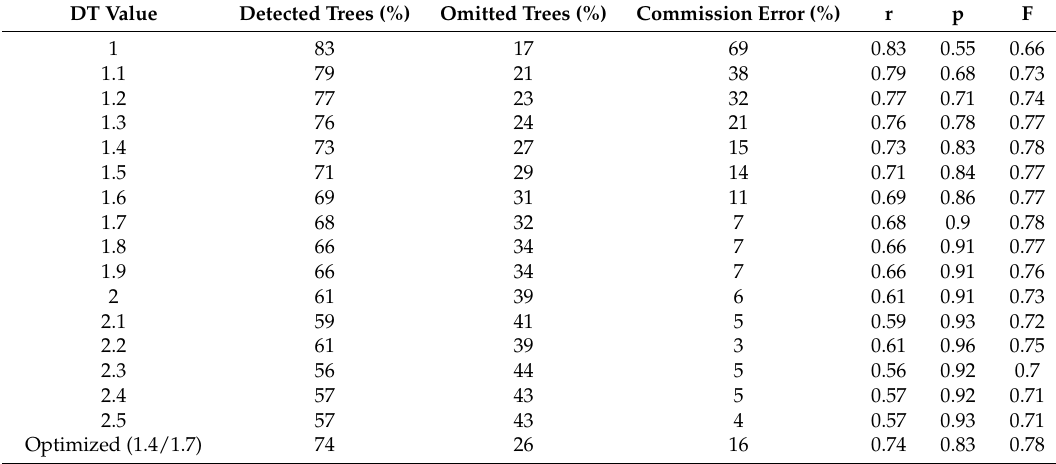
Table 3. Individual tree detection results for each iteration. A total of 192 trees were detected. The distance threshold (DT) value was changed by 0.1 m for each iteration to determine the effects of the parameter. The optimized iteration contains two DT values: 1.4 m for areas with more than 50% canopy cover, and 1.7 m for areas of 50% or less canopy cover. Recall (r), precision (p), and F-score (F) are standardized measures of detection, omission, and commission, respectively, calculated with Equations (2)–(4),